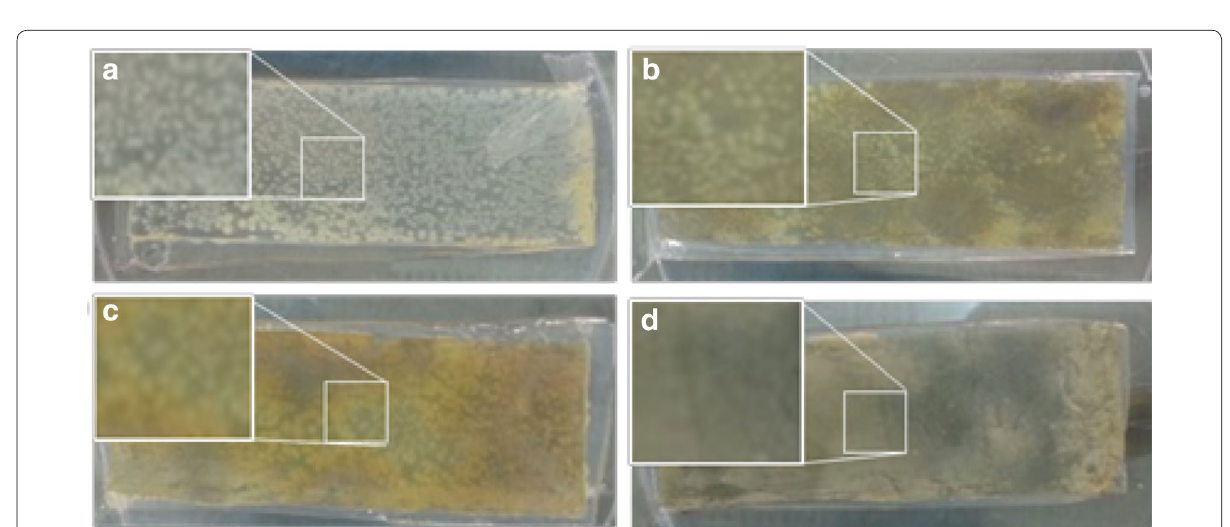
Fig. 7 Photographic images of an AgNP grown PDMS film at 36 h after inoculation of S . aureus on the surface. a Control PDMS was prepared with- out the AgNP growing reaction. From b to d , AgNP-grown PDMS films subjected to one, two, or three rounds of reactions, respectively. Inset in